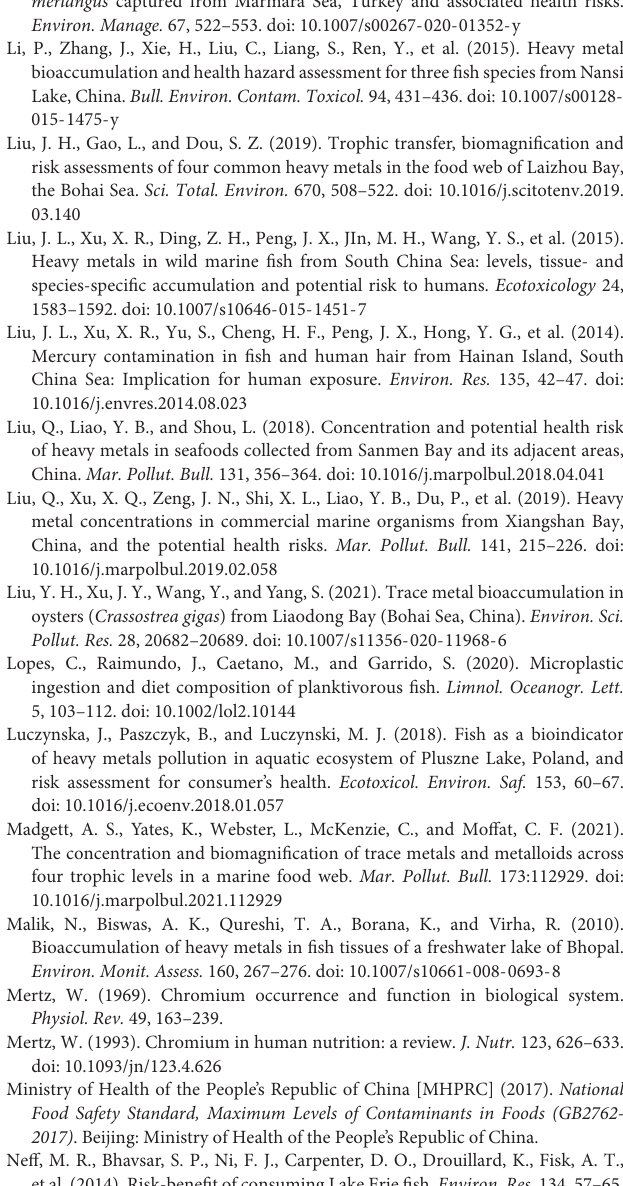
Table, Regional Screening Level (Rsl) Summary Table . Washington, DC: